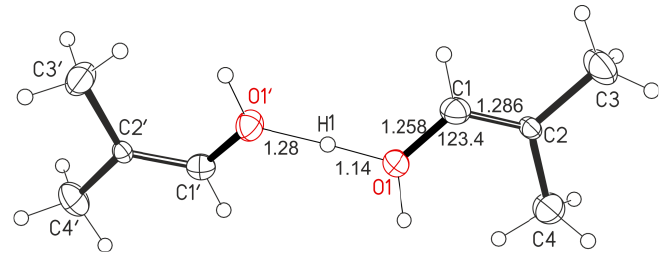
Figure 2. X-ray structure of the proton disolvate I а .